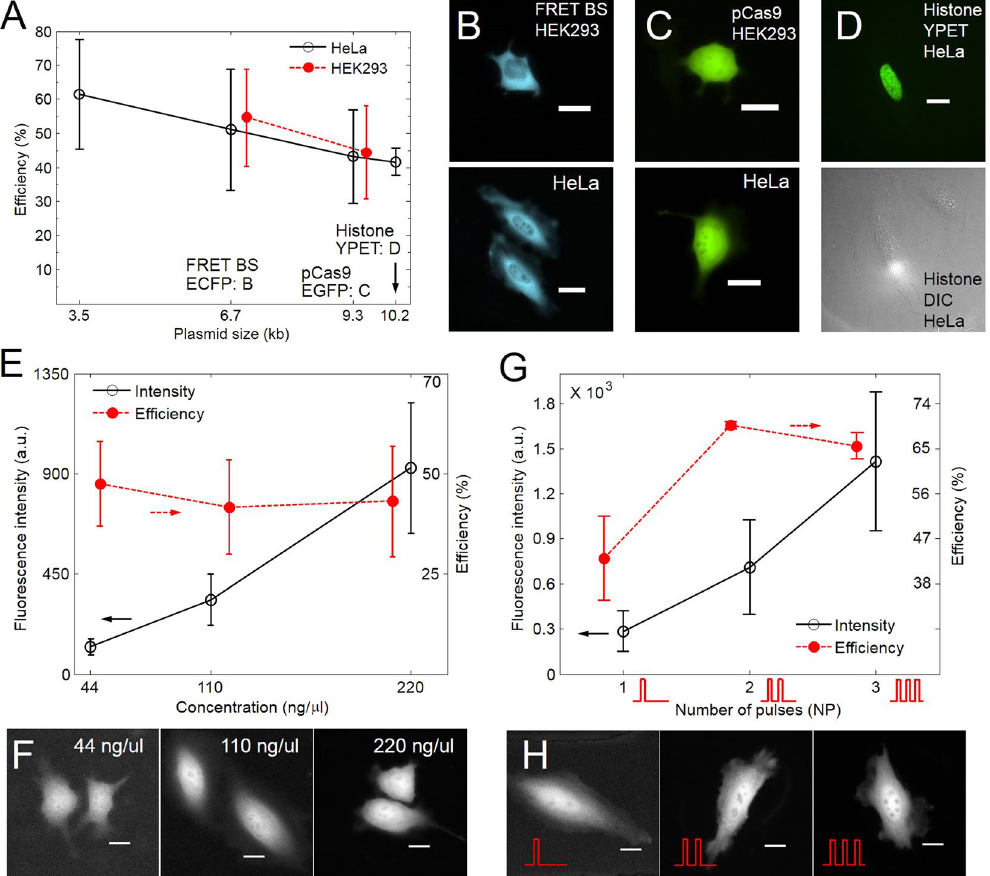
Figure 2. Gene expression level (fluorescence intensity) and delivery efficiency of acoustic-transfection depending on plasmid size and concentration as well as the NP. The Vp and tw of each electrical pulse was 22 V and 18 μ s, respectively and the NP was 1 unless otherwise indicated. For the NP = 2 and NP = 3 cases, the PRT was 0.5 s. ( A ) pMax-EGFP (3.5 kb), FRET-Ca 2 + -biosensor (BS) with ECFP (6.7 kb), pCas9-EGFP (9.3 kb), and Histone-H3-targeted-YPET (10.2 kb) plasmids were used. The concentration of plasmid was 110 ng/ μ l. For the HeLa cells, each data point was run two times and each run was performed on 6 to 21 cells. For HEK293 cells, each data point was run three times and each run was performed on 10 to 38 cells. Representative fluorescence images of the acoustic-transfected HEK293 (upper row) and HeLa (lower row) cells with ( B ) FRET-Ca 2 + -BS- ECFP and ( C ) pCas9-EGFP are shown. ( D ) Fluorescence (upper low) and DIC (lower row) images of the HeLa cells, acoustic-transfected with Histone-H3-targeted-YPET plasmids, is presented. The pCas9-EGFP and HeLa cells were used for ( E – H ). ( E ) For efficiency calculation, two independent experiments were performed at each data point and 17 to 21 cells were used for each experiment. Eight cells were randomly chosen and the fluorescence intensity was estimated. ( F ) Representative fluorescence images show the pCas9-EGFP expression after 24 hours under the concentrations of 44 ng/ μ l, 110 ng/ μ l, and 220 ng/ μ l. ( G ) Two independent experiments were run for the NP = 1, 2, and 3 cases with a concentration of 110 ng/ μ l. Each experiment used 16 to 21 cells. Thirteen cells were randomly chosen for fluorescence intensity calculation. ( H ) Representative fluorescence images of the pCas9-EGFP after 24 hours for the cases of NP = 1, 2, and 3 are shown. Error bars represents + / − one standard deviation (SD). Scale bars indicate 20 μ